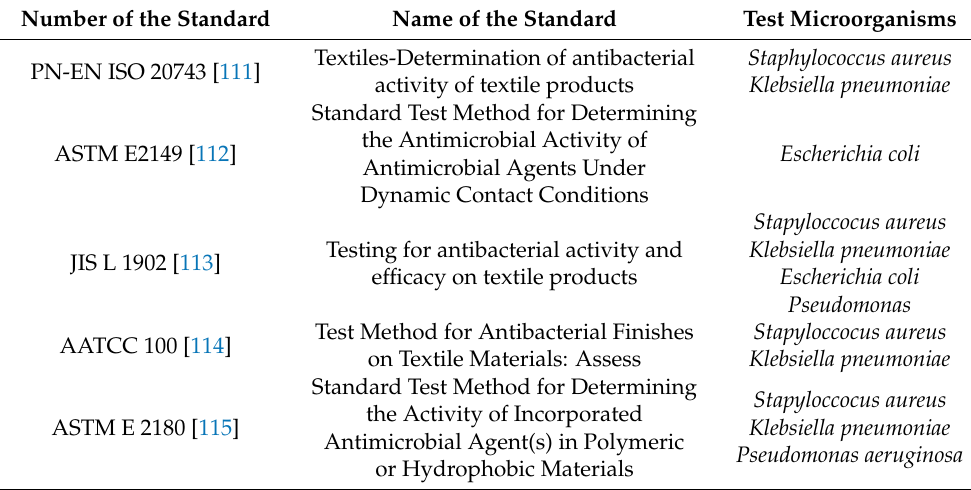
Table 5. Quantitative methods for assessing antimicrobial